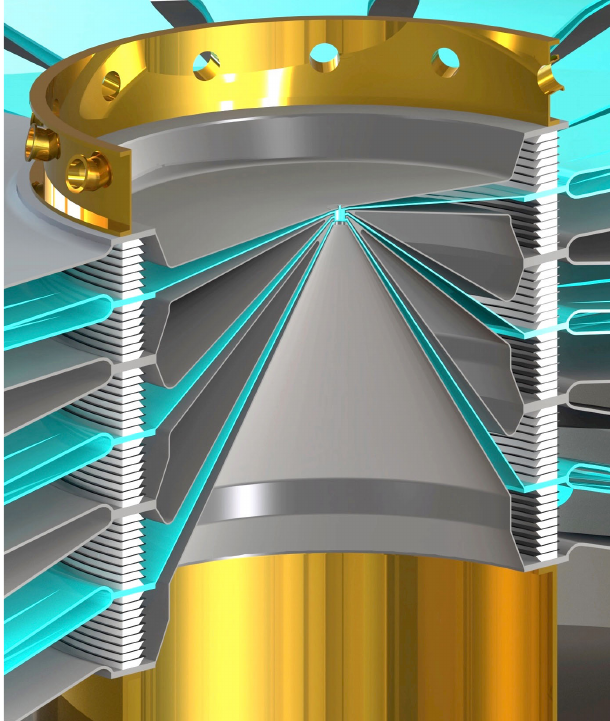
FIG. 4. Cross-sectional view of the centrally located vacuum section of Z 300. The section includes six water flares, six vacuum insulator stacks, six vacuum flares, and six conical outer MITLs. The six levels of this system are electrically in parallel. The outer radius of the stack is 2.39 m.